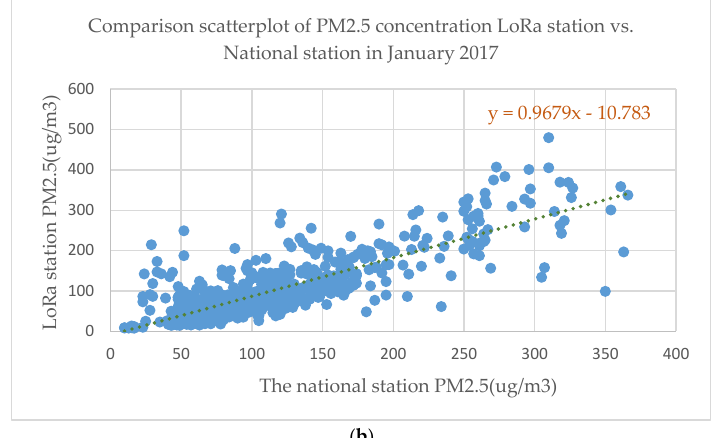
Figure 9. Comparison between the authoritative data that were issued by the national station and the LoRa device station for the concentration of PM2.5 in a month. ( a ) Comparison line graph of the national station data and the LoRa PM2.5 data in a month. ( b ) Comparison scatter plot of the national station PM2.5 data and the LoRa PM2.5 data in month.